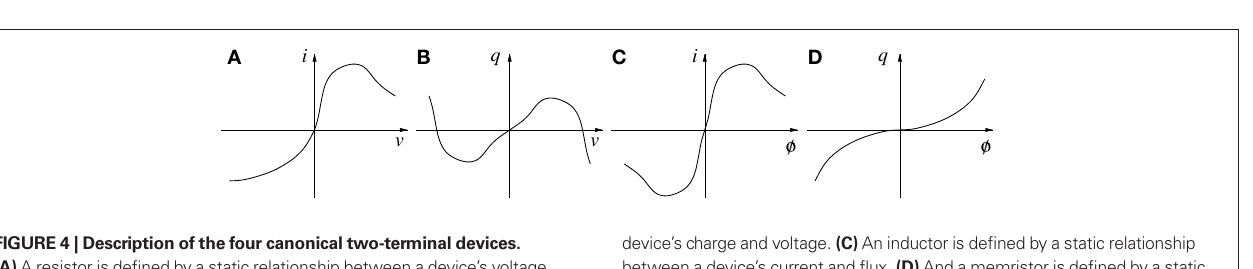
Figure 4 | Description of the four canonical two-terminal devices. (A) A resistor is defined by a static relationship between a device’s voltage and current. (B) A capacitor is defined by a static relationship between a